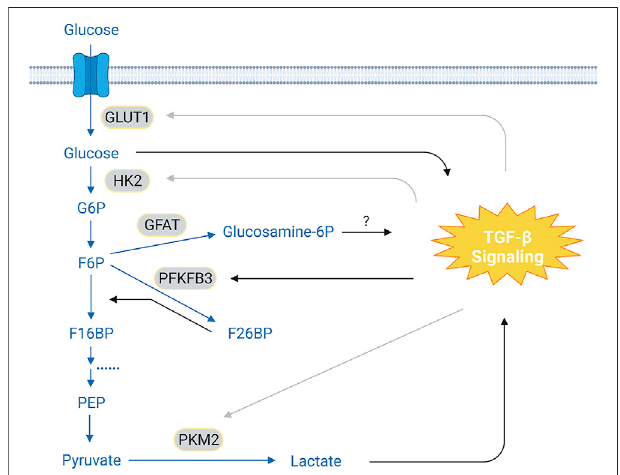
FIGURE 2 | Crosstalk Between TGF- β Signaling and Glycolysis. In the glycolytic pathway, glucose is converted to pyruvates via a cascade of enzymatic reactions. It has been reported that TGF- β signaling can either increase or decrease the expression of GLUT1 and HK2, depending on the cell types. This cell type-context effect is also seen on PKM2, an enzyme that catalyzes pyruvate into lactate. TGF- β signaling upregulates PFKFB3, leading to increased F26BP levels, which, in turn, accelerate conversion of F6P to F16BP. It has been suggested that glucose and lactate can promote TGF- β signaling; and inhibition of GFAT prevents glucose-induced expression of TGF- β ligands, implying a potential role of glucosamine-6-phosphotase in mediating this process. The conversion of F16BP to pyruvate has been omitted for clarity. Blue texts and arrows, glycolysis and its branches; gray arrows, cell-type dependent effect. Abbreviations: G6P, glucose-6- phosphate; F6P, fructose-6-phosphate; F16BP, fructose-1,6-biphosphate; F26BP, fructose-2,6-biphosphate; PEP, phosphoenolpyruvate; GLUT1, glucose transport 1; HK2, hexokinase 2; GFAT, glutamine:fructose-6- phosphate aminotransferase; PFKFB3, 6-phosphofructo-2-kinase/fructose- 2,6-biphosphatase 3; PKM2, pyruvate kinase M2. Figure is created with